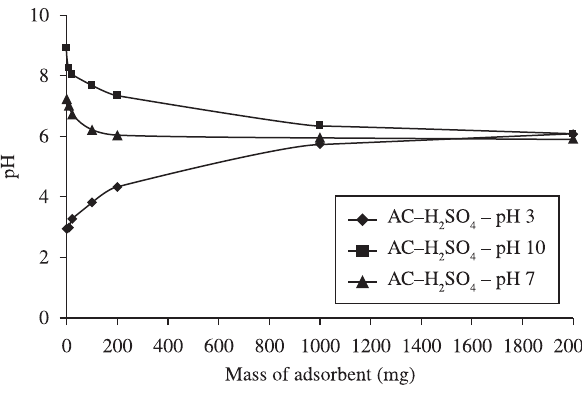
Figure 5. Point of zero charge of AC-H